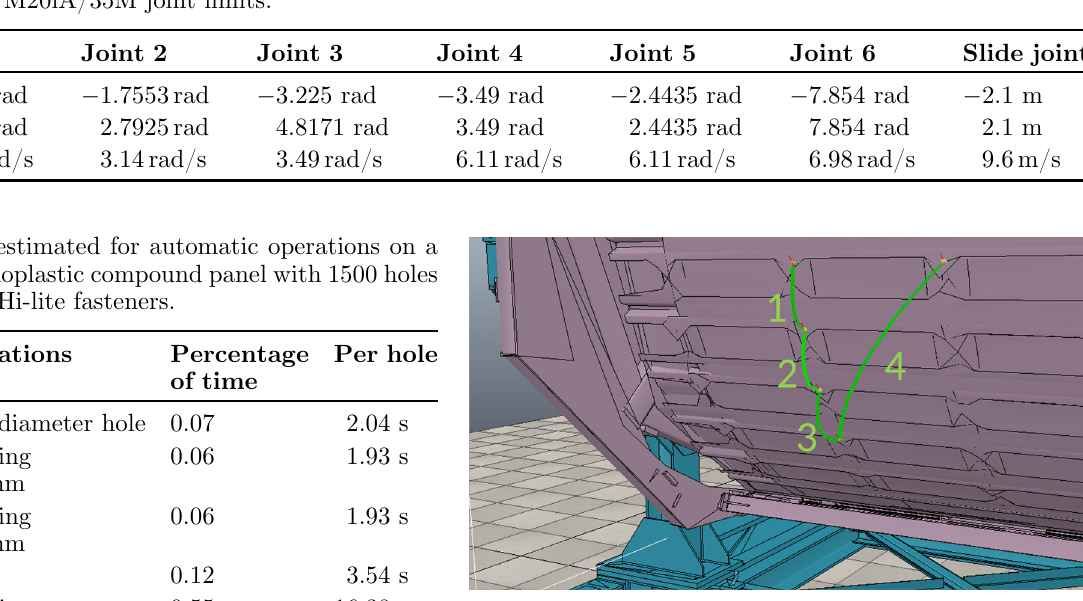
Fig. 4. Four task-space trajectories in the CoppeliaSim simula- tion